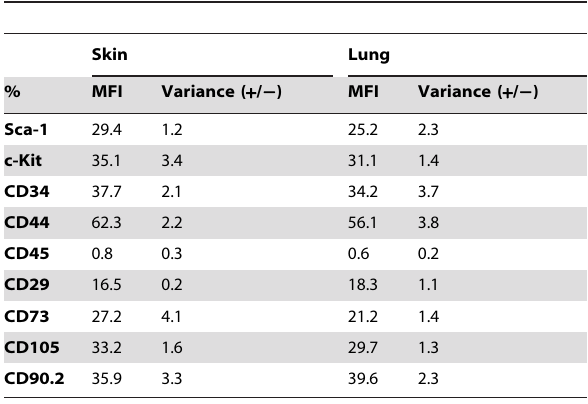
Table 1. Mean Fluorescence Intensity (MFI) of skin and lung MPCs surface